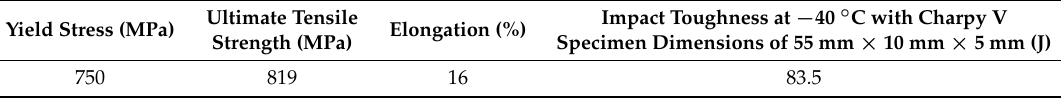
Figure 1. Microstructure of Q690E HSLA (High strength low alloy) steel. Table 1. Mechanical properties of Q690E steel.